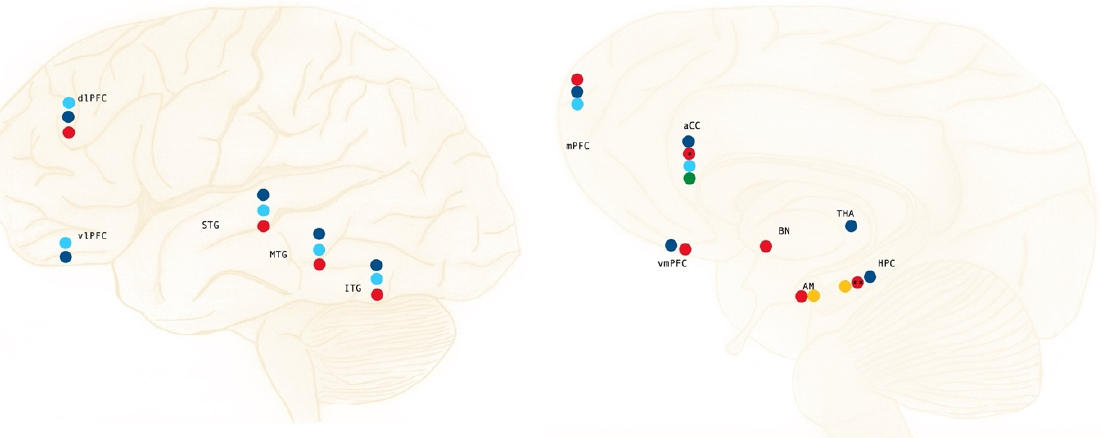
Figure 1. Summary of the areas and structures mostly affected by reorganization processes in PTSD; hypoactivation/under engagement under symptom provocation (dark blue), decreased white matter volume (light blue), decreased gray matter volume (red), hyperactivation during threat detection (green), and hyperactivation/over engagement during symptom provocation (orange). * Adaptation more prominent on the left-brain hemisphere; ** Contradictory evidence regarding laterality.